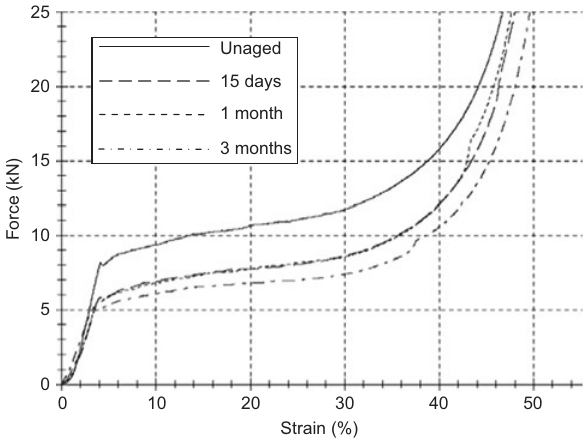
Figure 5 Compression curves of MS3 aged at 100 ° C.